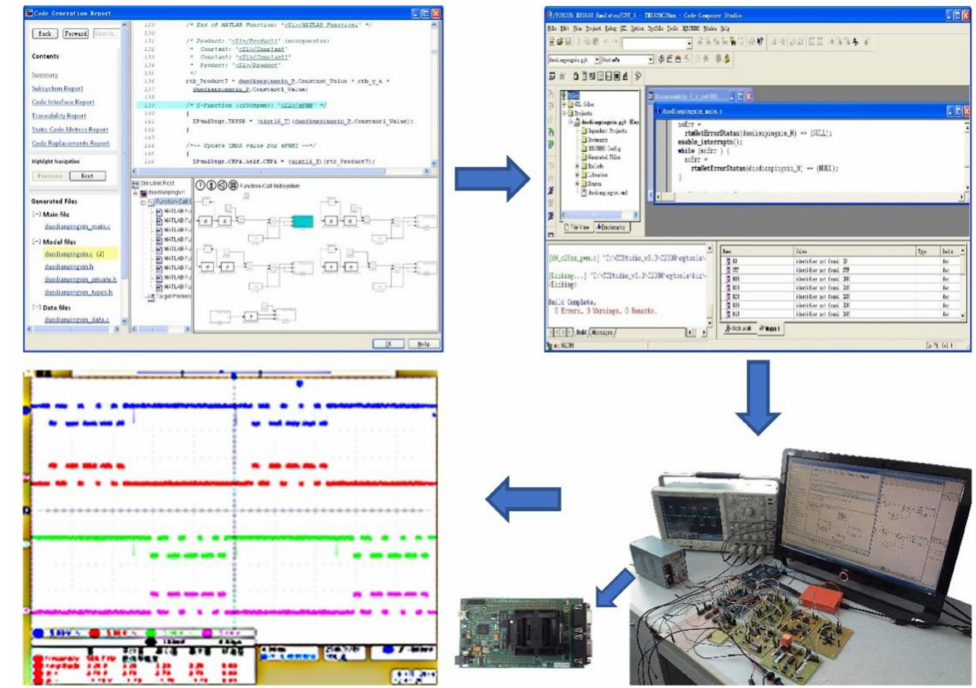
Figure 10. Process of code